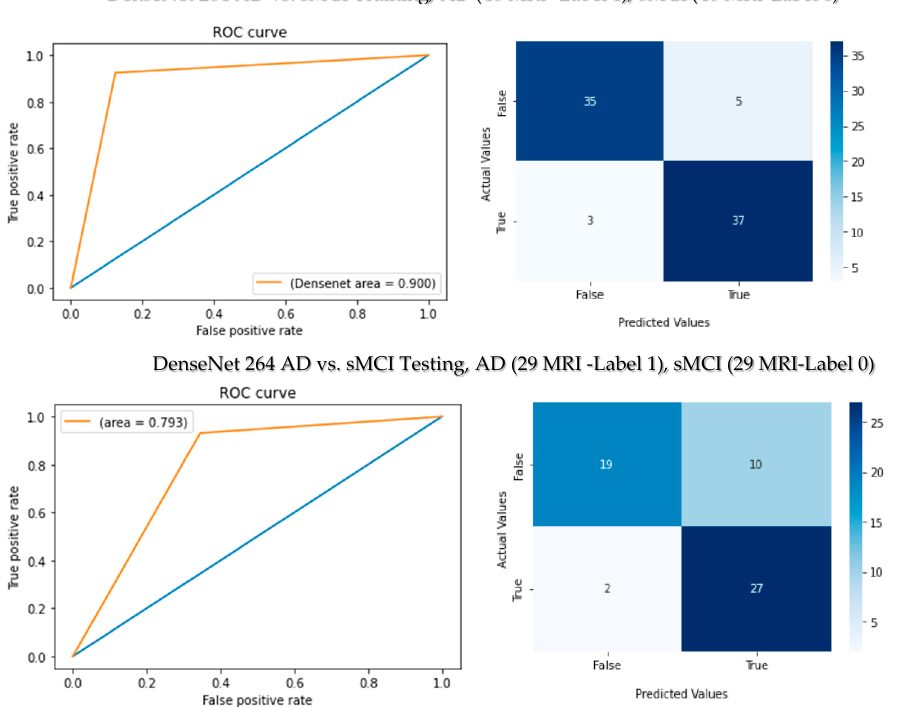
Figure 6. Confusion matrix and ROCAUC for DenseNet264’s best fold of AD vs. sMCI classification.